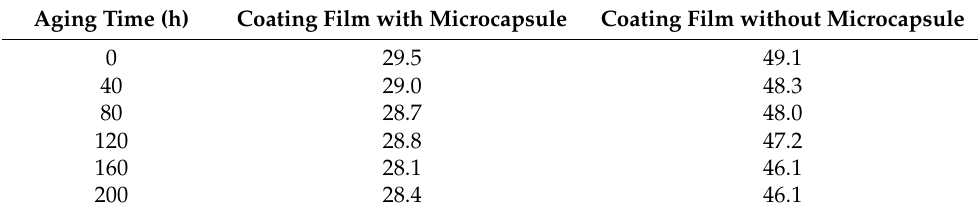
Table 9. Glossiness of coating film under UV aging